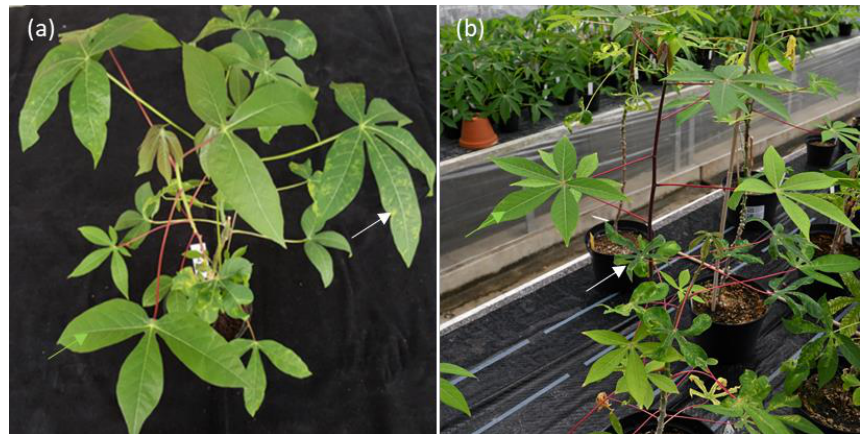
Figure 4. Virus resistance testing of cassava seedlings under controlled glasshouse conditions. ( a ) Typical CBSV symptoms (white arrow) of CBSV-infected scion (green petiole) used for graft infection. Virus-infected rootstock (red petiole) remains free of symptoms (white arrow). ( b ) Absence of symptoms (green arrow) in CBSV-resistant rootstock (from ( a )) after graft infection with UCBSV/ EACMV indicates broad-spectrum resistance against EACMV and U/CBSV. Typical EACMV symptoms on EACMV-infected scion (white arrow).